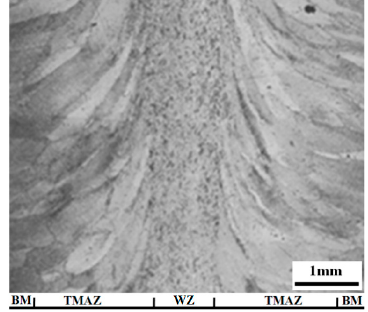
Figure 7. Morphology of TC17 LFW joint in the X–Z plane.